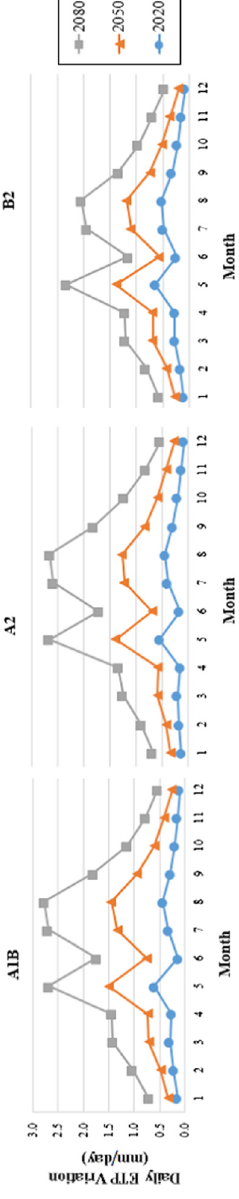
Figure 3. Daily ETP changes compared with the observed period